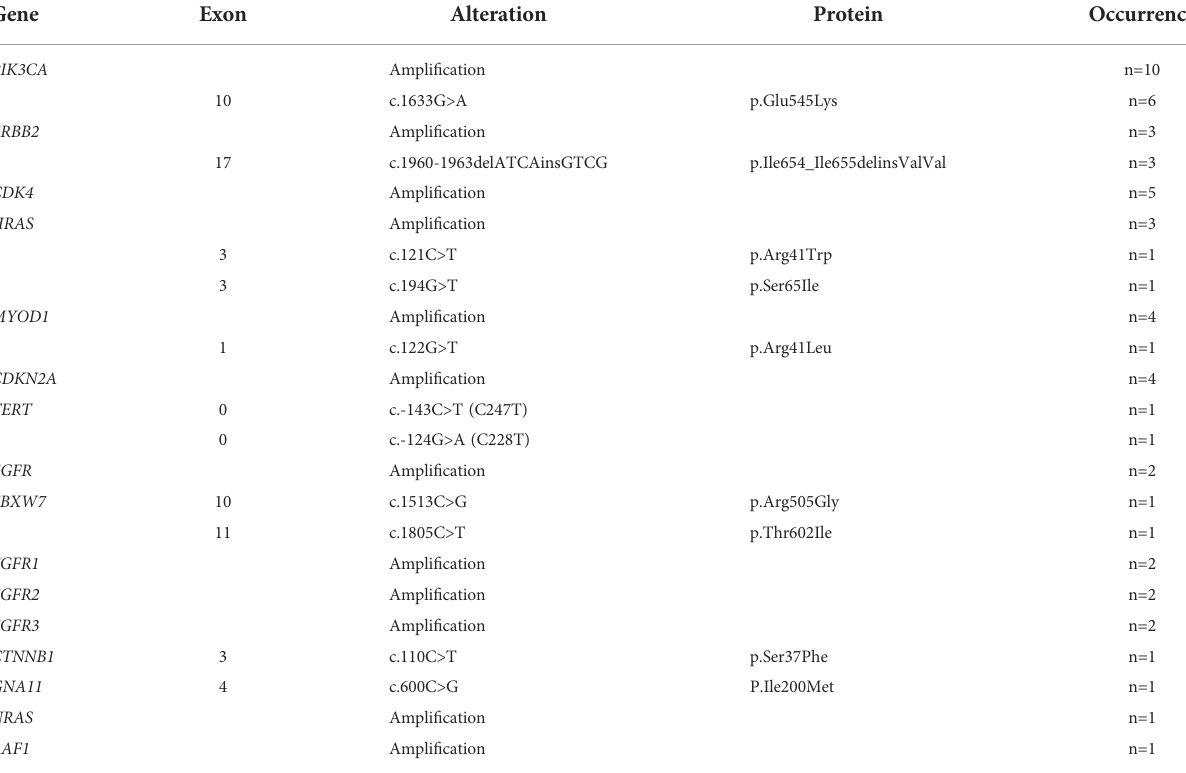
TABLE 7 Summary of somatic mutations retrieved among SCCA from the HPV02